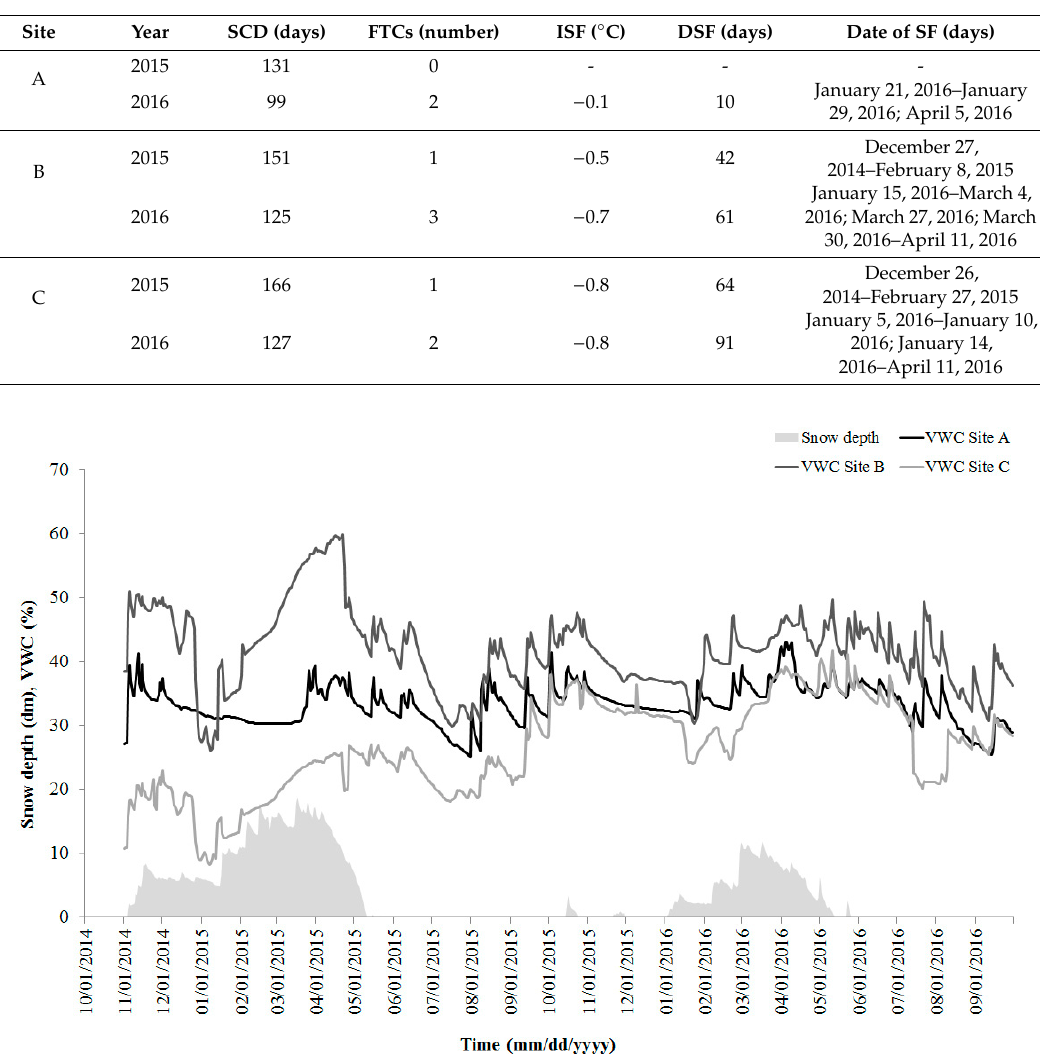
Table 3. Snow cover duration (SCD), number of freeze / thaw cycles (FTCs), intensity of soil freezing (ISF), cumulative days of soil freezing (DSF), and period of soil freezing (Date of SF) in each study site measured over the two years.